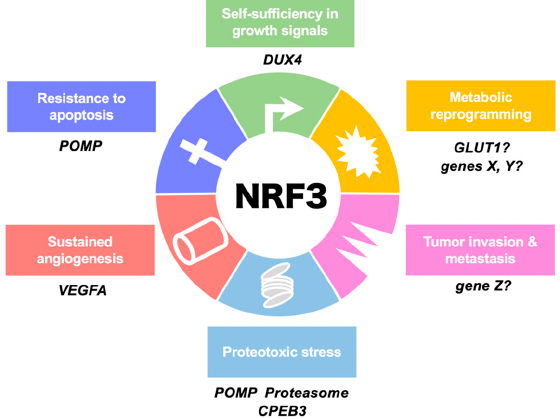
Figure 1. High upregulation of the NFE2-related factor 3 (NRF3) gene with malignancy. ( A ) Box plots depict the NRF3 gene expression profiles across multiple cancer types and in paired normal samples from the Gene Expression Profiling Interactive Analysis 2 (GEPIA2) web server [16]. Each red and gray box represents a tumor and adjacent normal specimen, respectively. * p < 0.05. BLCA, bladder urothelial carcinoma; CESC, cervical squamous cell carcinoma and endocervical adenocarcinoma; CHOL, cholangiocarcinoma; COAD, colon adenocarcinoma; DLBC, diffuse large B-cell lymphoma; ESCA, esophageal carcinoma; GBM, glioblastoma multiforme; HNSC, head and neck squamous cell carcinoma; KIRC, kidney chromophobe; OV, ovarian serous cystadenocarcinoma; PAAD, pancreatic adenocarcinoma (it is also annotated as PDAC—pancreatic ductal adenocarcinoma); READ, rectum adenocarcinoma; STAD, stomach adenocarcinoma; TGCT, testicular germ cell tumors; THCA, thyroid carcinoma; THYM, thymoma; UCEC, uterine corpus endometrial carcinoma; UCS, uterine carcinosarcoma. ( B ) Kaplan–Meier analyses comparing overall survival between groups expressing higher and lower levels of NRF3. The hazard ratio (HR) was calculated on the basis of Cox’s proportional hazards model. Data are from patients with PAAD and KIRC from GEPIA2.